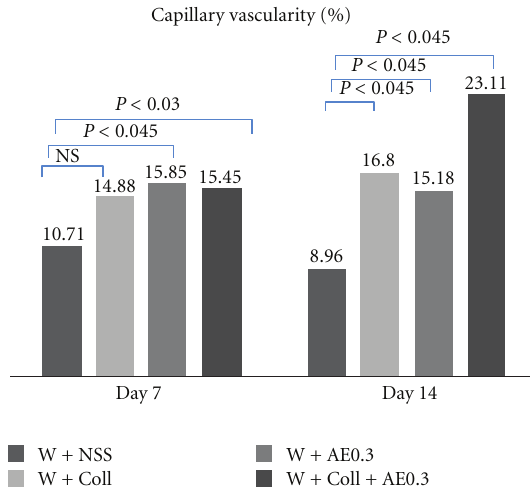
Figure 5: Capillary vascularity (CV) measured at the di ff erent timepoints (days 7 and 14) in the W-NSS, W-AE, W-Coll, and W- Coll-AE groups. Values are expressed as mean ±